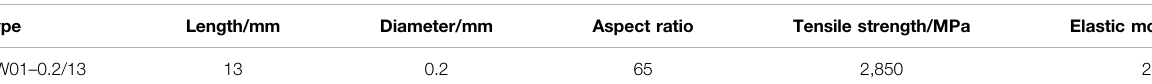
TABLE 2 | Steel fi ber properties.